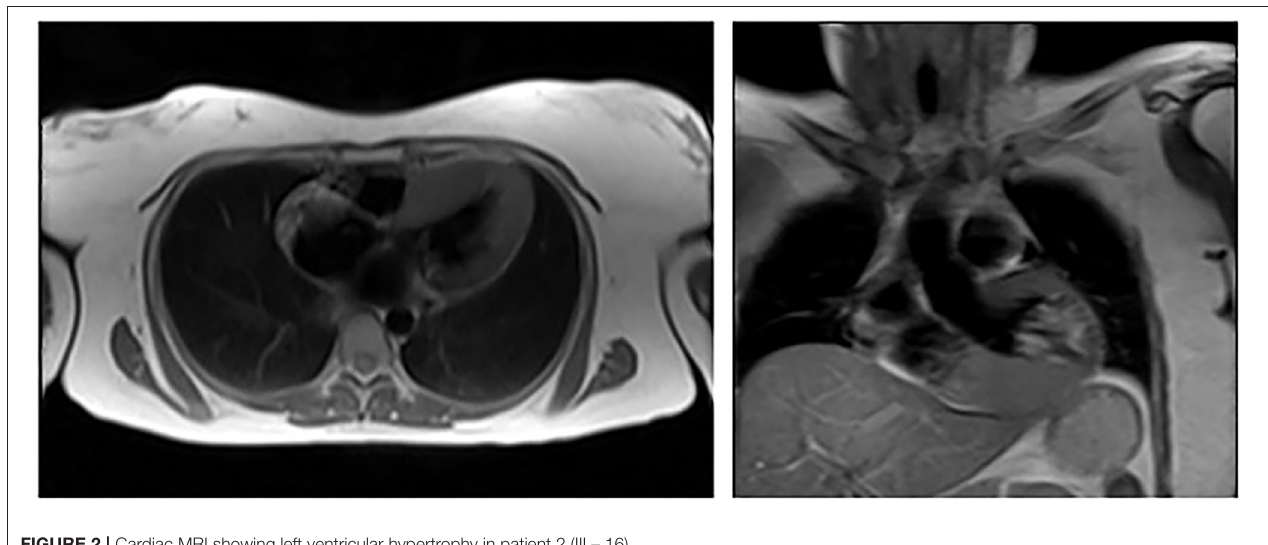
FIGURE 2 | Cardiac MRI showing left ventricular hypertrophy in patient 2 (III – 16).